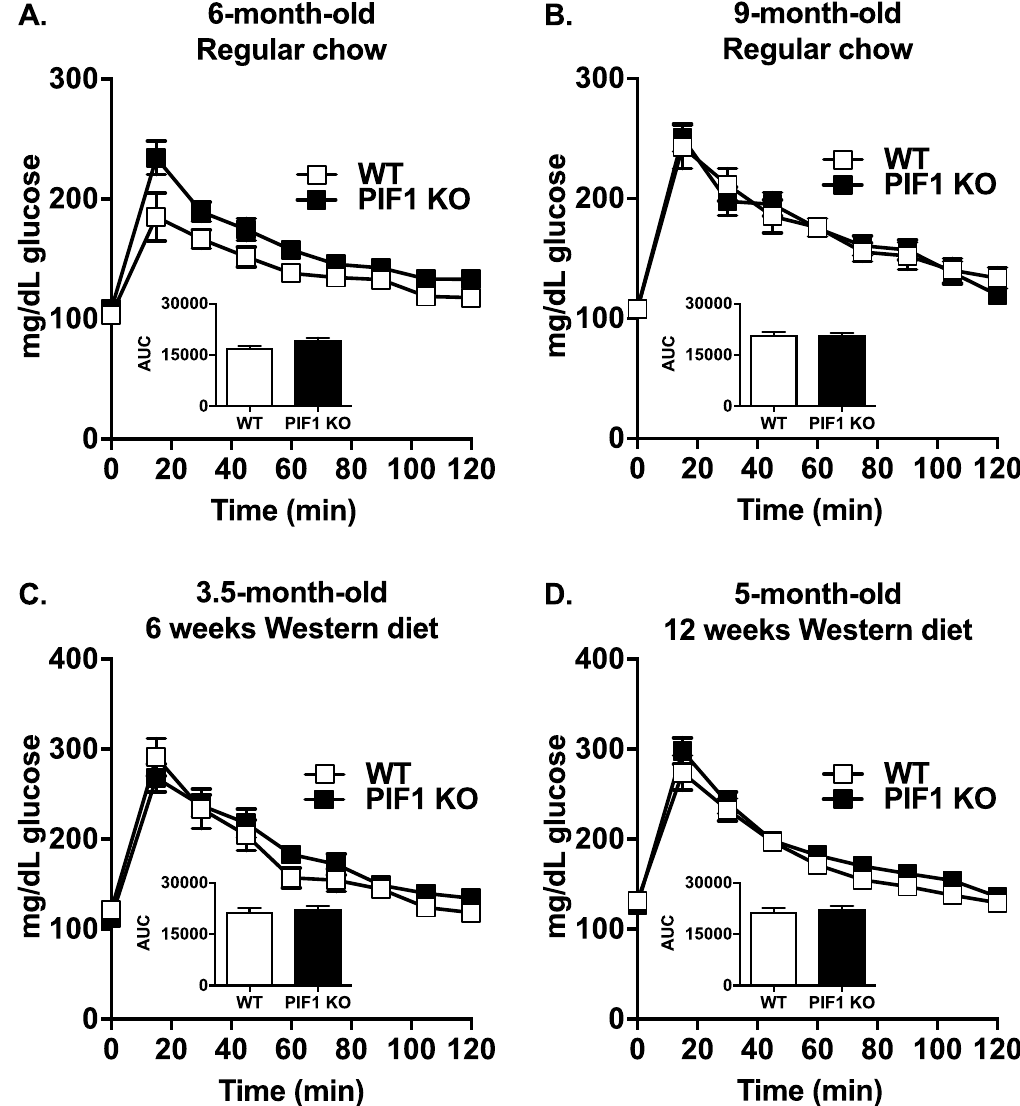
Fig 4. Western diet (WD) feeding did not affect blood glucose clearance in regular chow- and WD-fed PIF1 KO mice. A) Glucose tolerance tests were performed on six-month-old WT and PIF1 KO mice after 20 weeks of regular chow feeding, and on B) the same mice at nine months of age after 32 weeks of regular chow feeding. C) Glucose tolerance tests conducted on 3.5-month-old WT and PIF1 KO mice after 6 weeks of WD feeding, and D) 5-month-old WT and PIF1 KO mice after 12 weeks of WD feeding. All data are mean ± SEM; n = 8–12 mice per group; mg/dl = milligrams per deciliter; AUC = area under the curve. No data are significant by Student’s